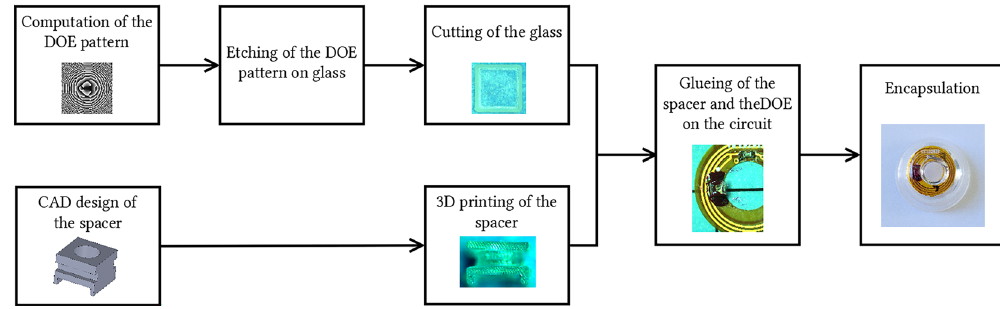
Figure 12. Diagram representing the main steps for the manufacturing of the contact lens embedded holographic